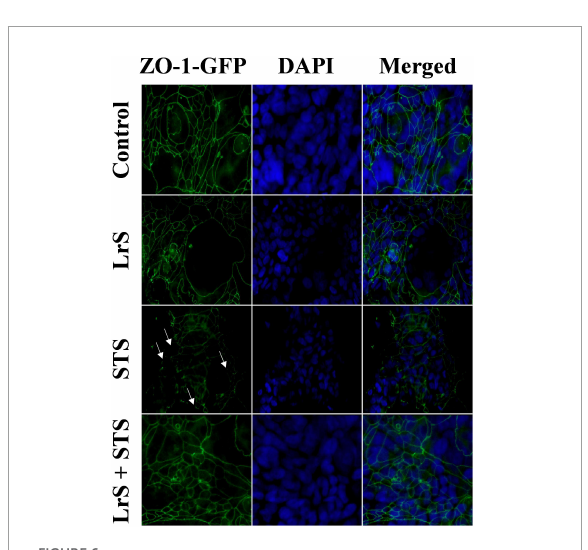
FIGURE6 The LrS attenuates STS-induced damage to T84 IEC monolayer and integrity by antagonizing STS damage to ZO-1. Confluent T84 IECs were stained with anti-ZO-1-GFP and counterstained with DAPI following 24 h of challenge with the LrS, STS, LrS + STS, or medium controls and visualized at 100X under oil